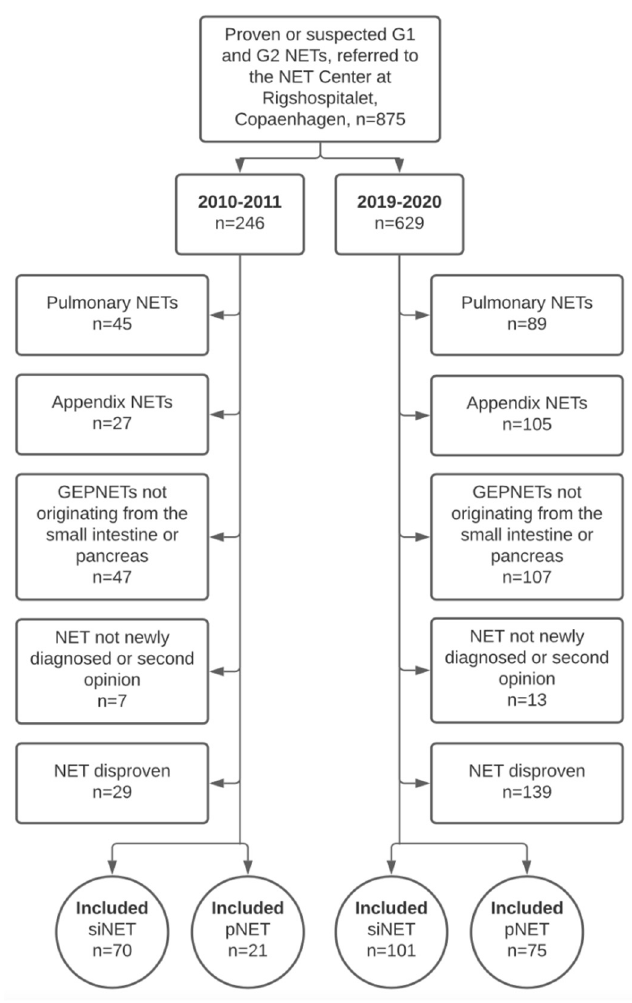
Figure 1. Flowchart illustrating patient selection. Flowchart illustrating excluded patients and the number of small intestinal and pancreatic NETs included. Abbreviations: Neuroendocrine Tumor (NET). Small intestinal NET (siNET). Pancreatic NET (pNET) Gastroenteropancreatic NET